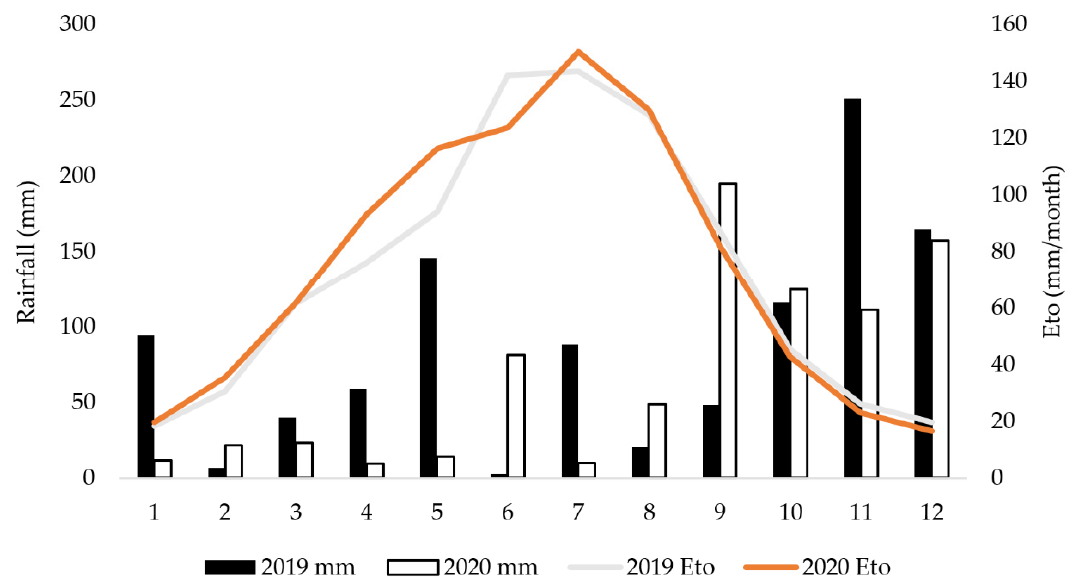
Figure 1. Monthly rainfall and monthly reference evapotranspiration in 2019 and 2020, from Žman, Dugi otok. ETo—reference evapotranspiration (obtained from the PinovaMeteo meteorological station [23]).